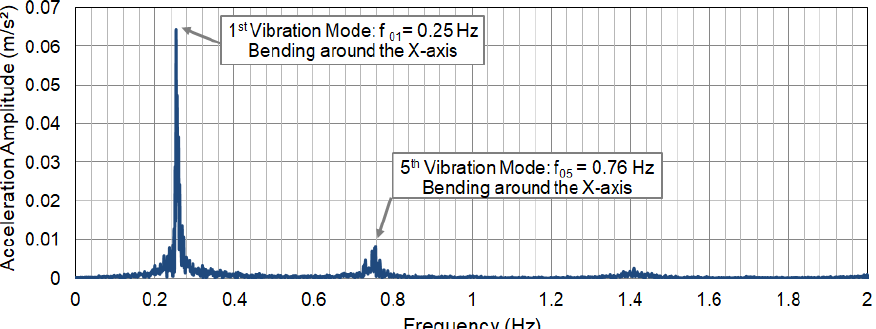
Figure 13. Example of acceleration at 87 meters high in the frequency domain (period of recurrence of 10